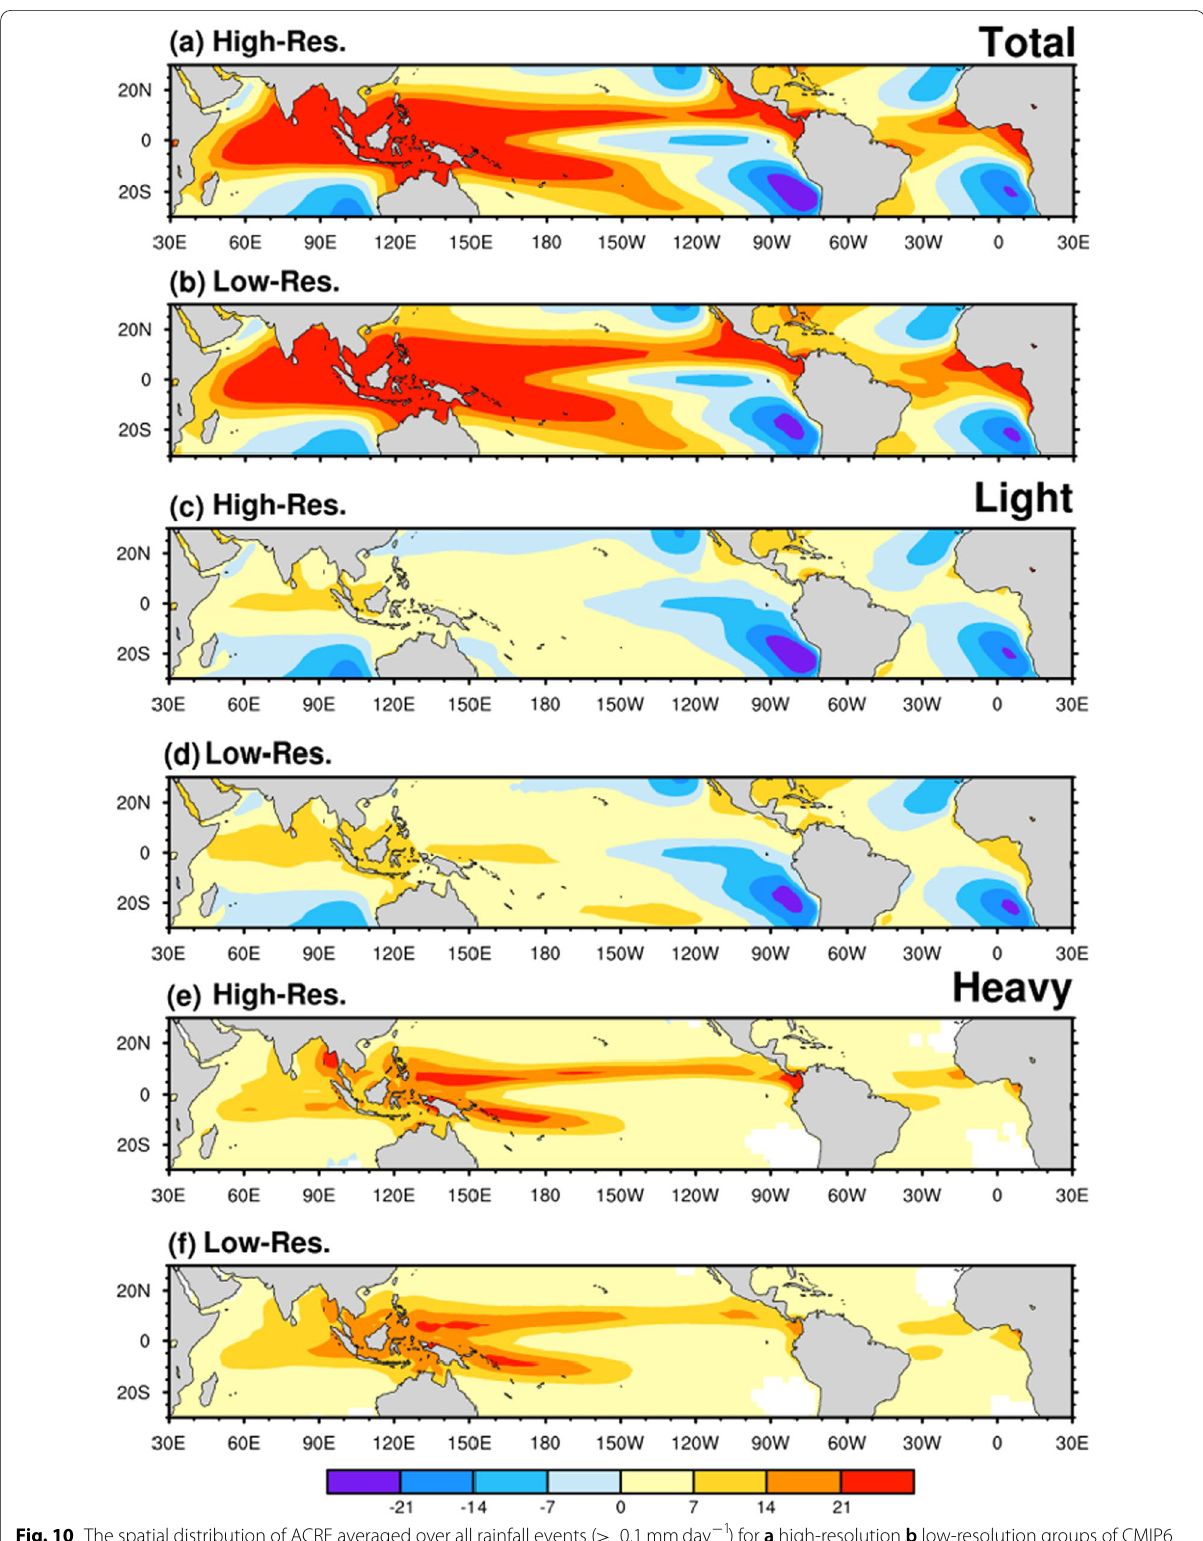
Fig. 10 The spatial distribution of ACRE averaged over all rainfall events ( > 0.1mmday − 1 ) for a high‑resolution b low‑resolution groups of CMIP6 models. Likewise, c and d show ACRE distribution averaged only over light rain events ( < 5mmday − 1 ) while e , f show ACRE distribution averaged only over heavy rain events ( > 10mmday − 1 ), respectively, for the high and low‑resolution groups. The color interval is 7 wattm −